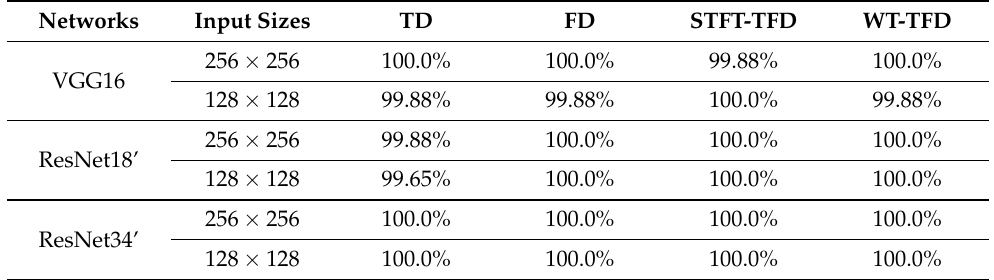
Table 5. Test accuracies of UoC.